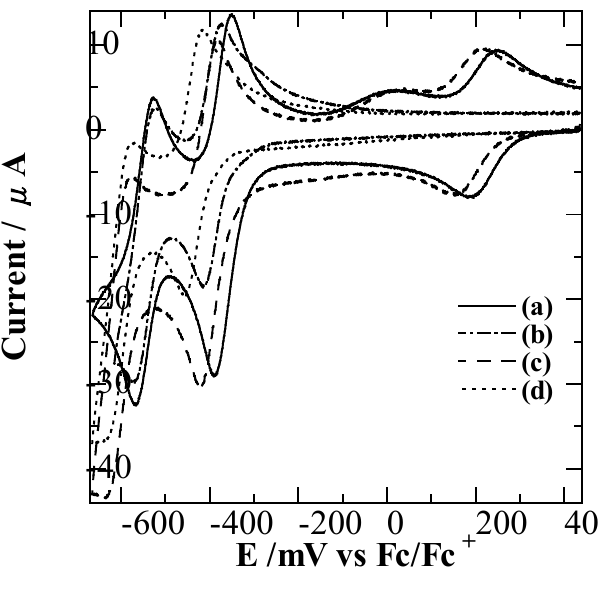
Figure A1. Cyclic voltammograms of (a) [As 2 VW 17 O 62 ] 7- , (b) [As 2 W 18 O 62 ] 6- , (c) [P 2 VW 17 O 62 ] 7- , and (d) [P 2 W 18 O 62 ] 6- in 95% (v/v) CH 3 CN containing 0.1 M HClO 4